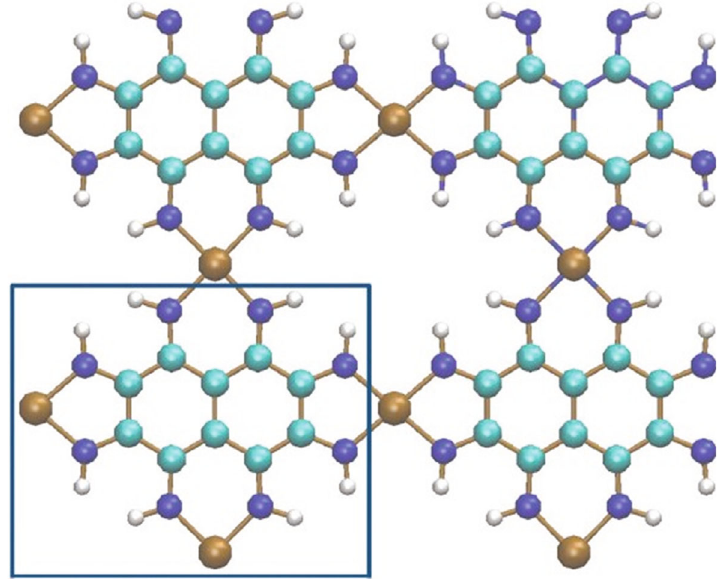
Figure 2: Top view of the 2D metal-organic p , q Þ depending on degrees of 2 ð